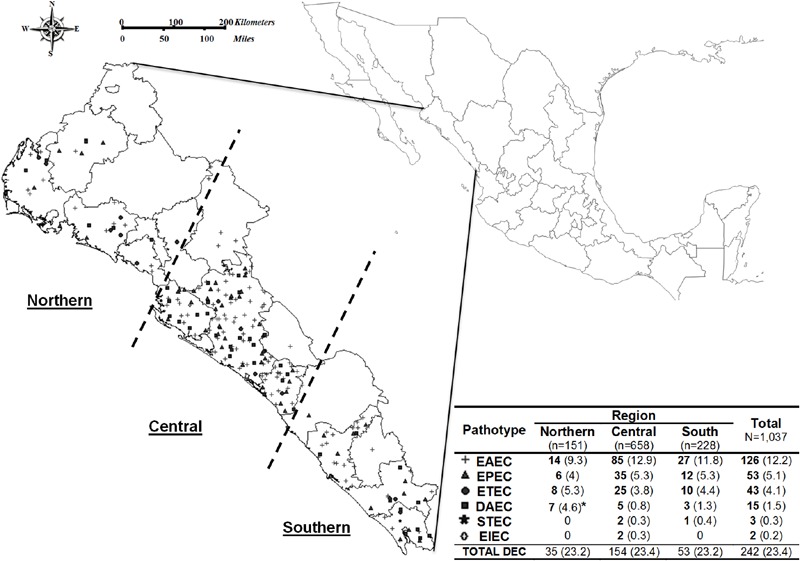
Diarrheagenic Escherichia coli distribution was described in three geographical zone. Northern (Incluide the municipalities of Ahome, El Fuerte, Choix, Sinaloa de Leyva, Guasave, Mocorito and Angostura), Central (Salvador Alvarado, Culiacan, Navolato, Badiraguato, Cosala and Elota) and South (San Ignacio, Mazatlan, El Rosario, Concordia and Escuinapa).